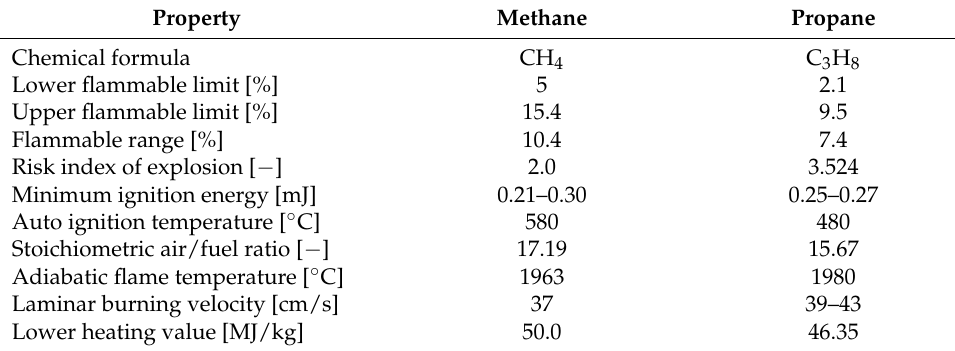
Table 2. Properties of methane and propane [23,24].